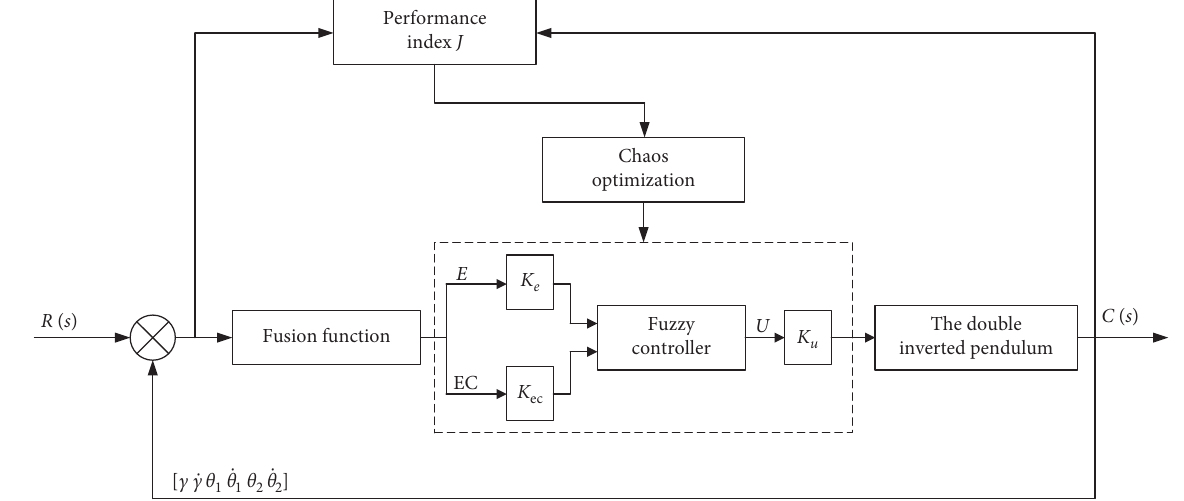
Figure 2: The structure chart of fuzzy control. Table 2: Fuzzy rules